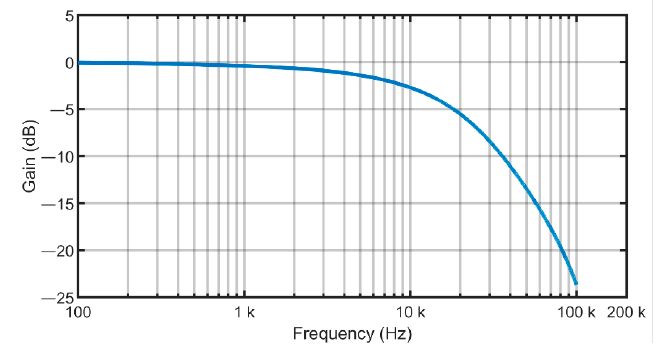
Table 4. Comparison of the Frequency Response values of the developed and the commercial device system NI DAQ 9775 [38].